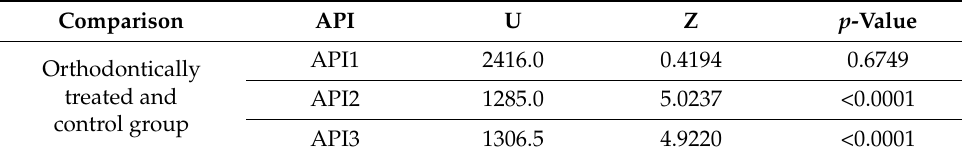
Table 3. ANOVA Friedman and Wilcoxon pairwise test values for the Approximal Plaque Index (API). Group ANOVA Friedman p -Value Comparison Orthodontically treated group